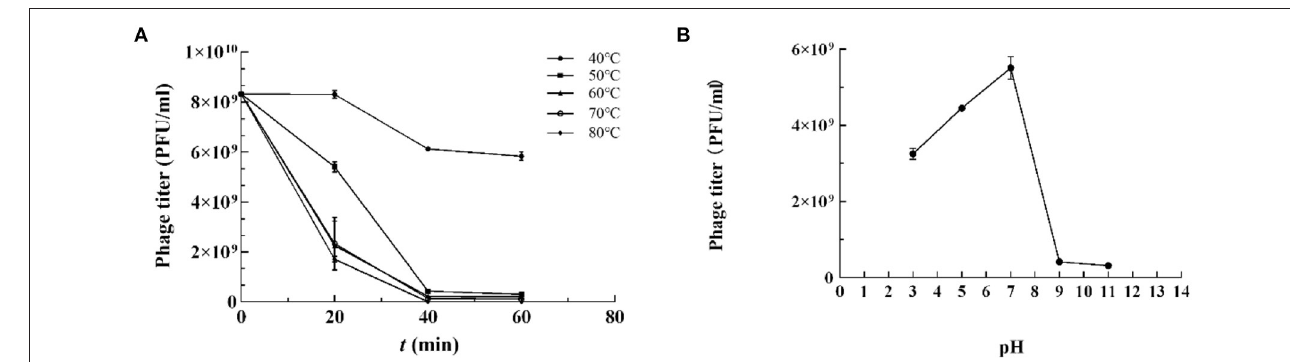
FIGURE 2 | Resistance of K. pneumoniae phage vB_Kpn_B01 to temperature. (A) Resistance of phage to temperature; (B) Resistance of phage pH.